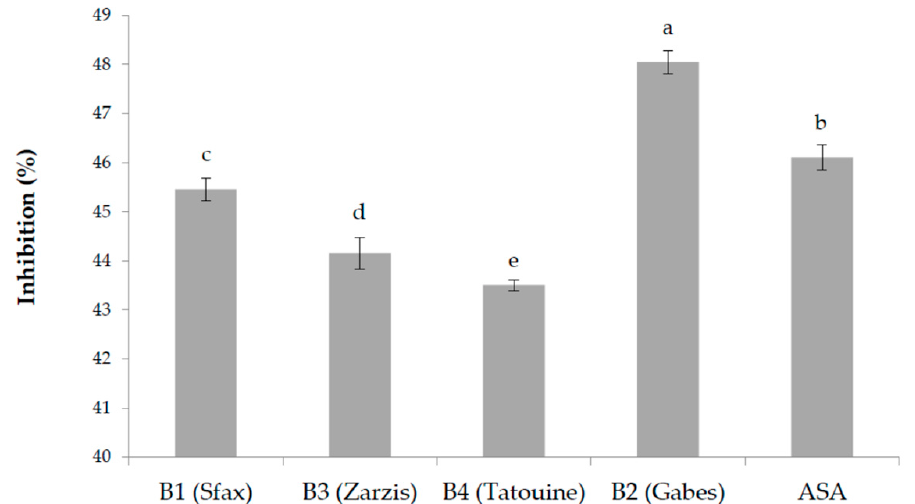
Figure 1. Anti-inflammatory activity of the different methanolic extracts (100 µ g/mL) of the tested